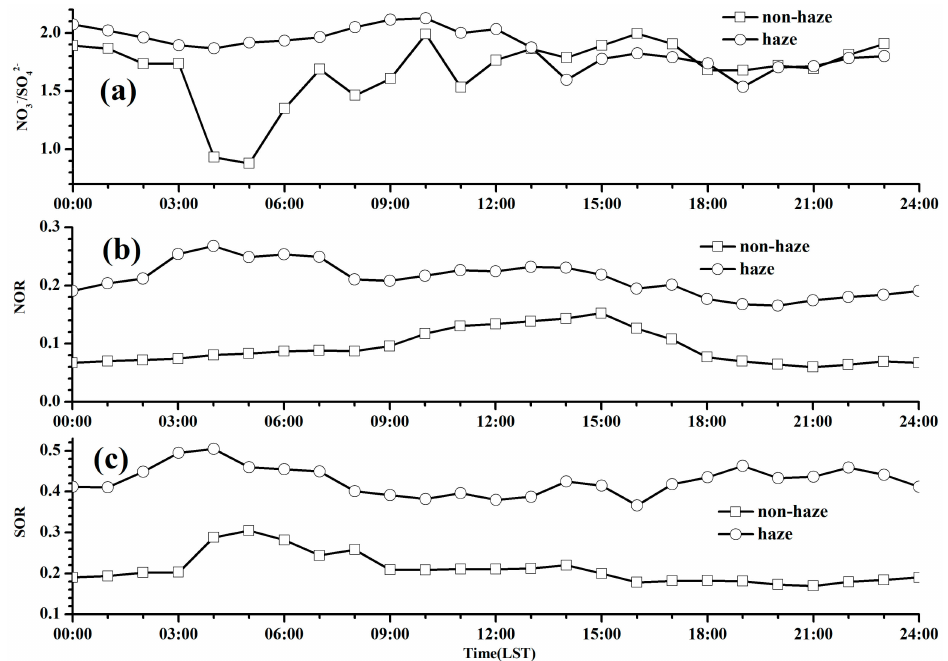
Figure 9. Diurnal variations of NO 3 − / SO 42 − ( a ), nitrate oxidation rate (NOR) ( b ) and sulfate oxidation rate (SOR) ( c